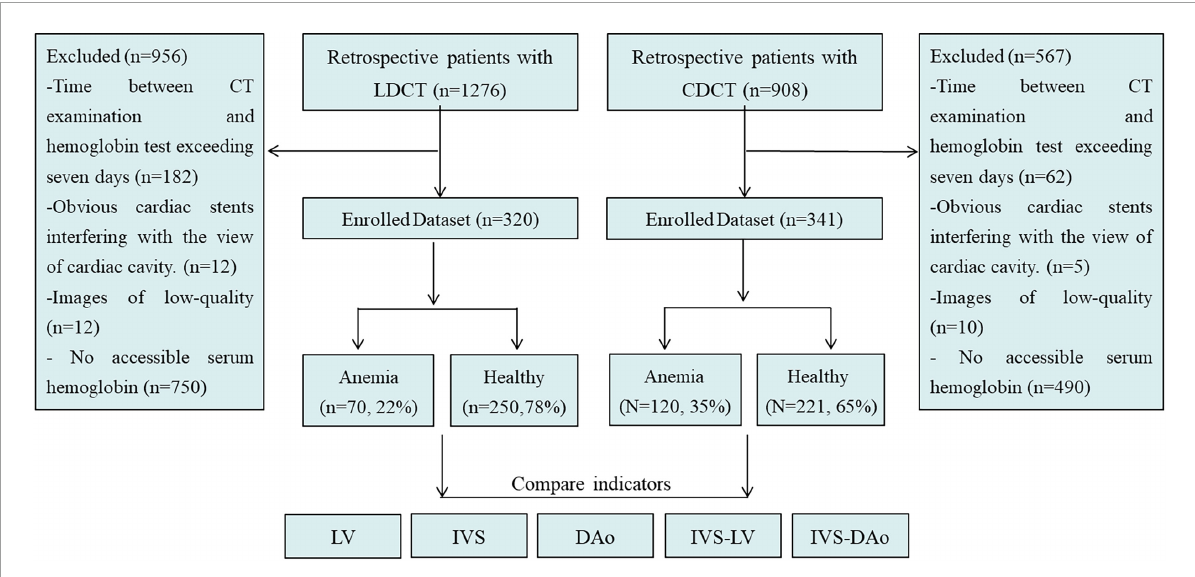
FIGURE1 Patient flow diagram. LDCT, low dose computed tomography; CDCT, conventional dose computed tomography; IVS, interventricular septum; LV, left ventricular cavity; IVS-LV, CT attenuation difference between LV and IVS; DAo, descending aorta; IVS-DAo, CT attenuation difference between DAo and